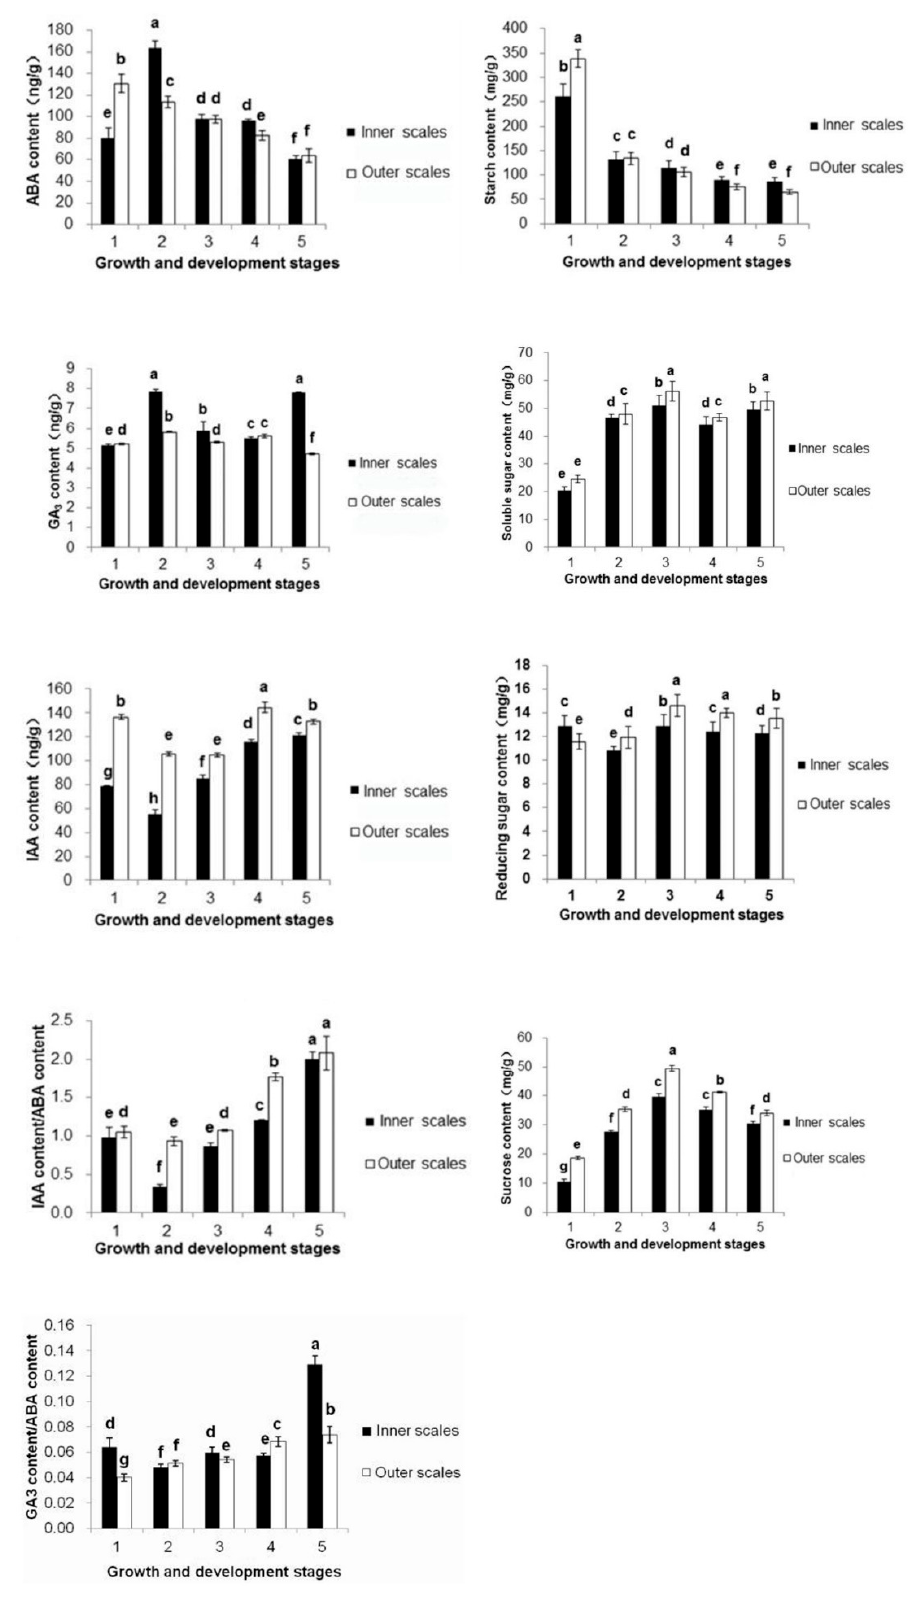
Figure 4. Development of Lily bulbs were divided into five major periods, before vernalization, vernalization, after vernalization, flower bud di ff erentiation, and flower bud development. In order to explore the role of carbohydrate metabolism, changes of carbohydrates and hormones contents in lily bulbs were measured at the physiological level.